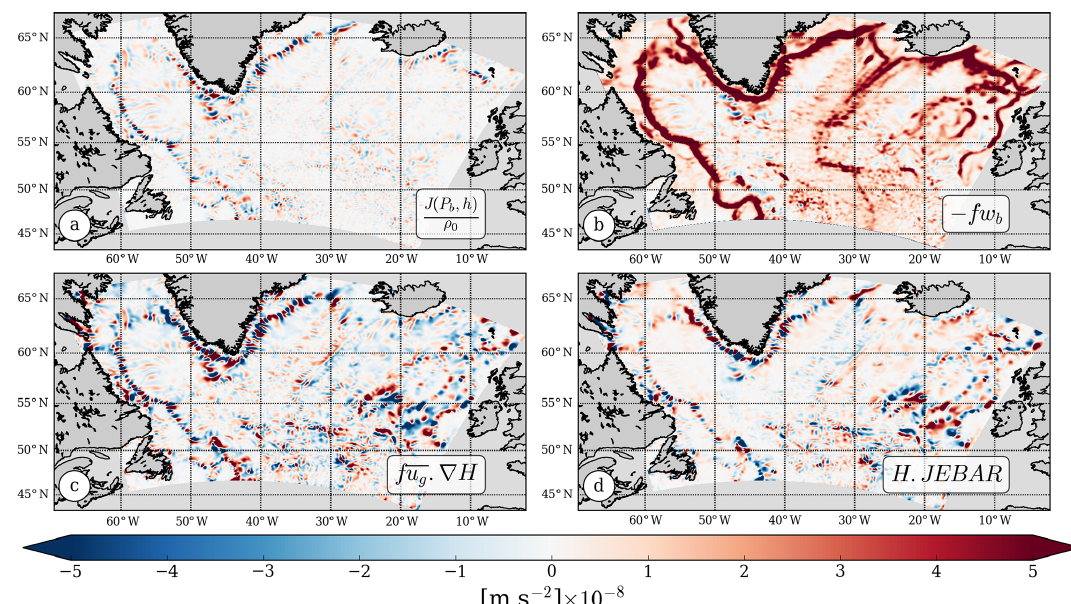
u g ·∇ H , and (d) H · JEBAR for the 2km North Atlantic subpolar gyre simulation h